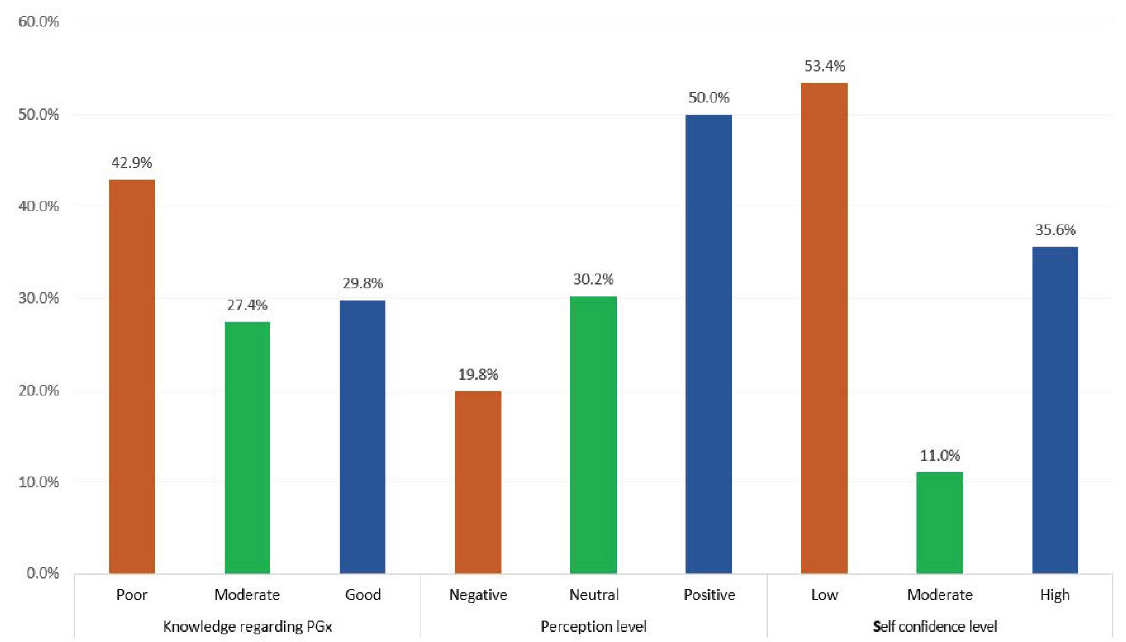
Figure 1. Knowledge, perception, and self-confidence among pharmacists working in KSA regard- ing PGx.